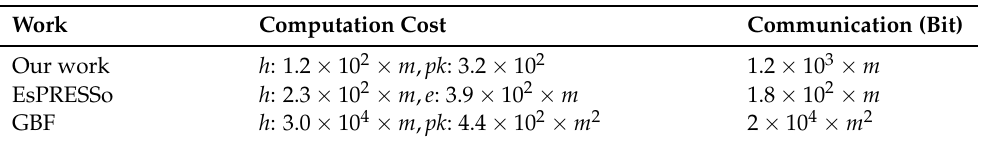
Table 3. Comparison of computational and communication costs ( h : time required to implement hash;